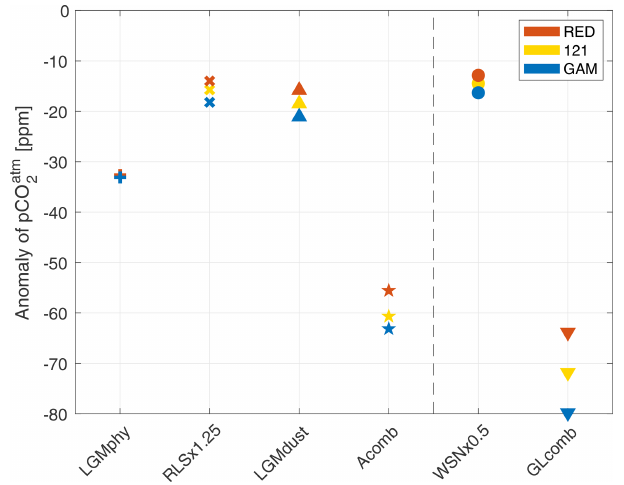
Figure 6. Resulting CO 2 anomaly, with respect to the control- state 278ppm, of the sensitivity experiments LGMphy (plus sym- bol), RLS × 1 . 25 (times symbol), LGMdust (upward arrowheads), and WSN × 0 . 5 (circles) and of the combined experiments Acomb (stars) and GLcomb (downward arrowheads). Results of the differ- ent model versions RED, 121, and GAM are shown in red, yellow, and blue respectively. The vertical dashed line separates simulations without (left) and with (right) wind